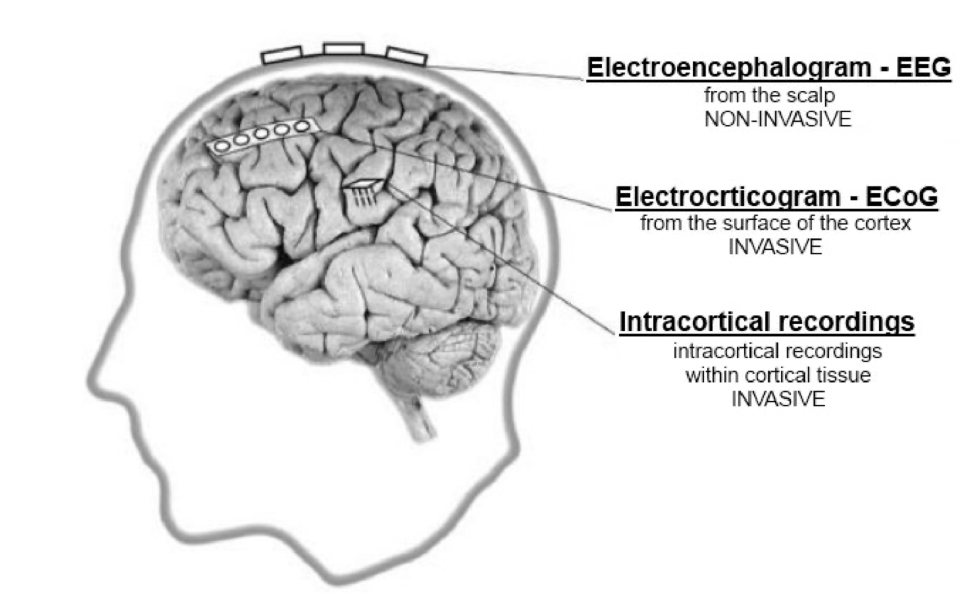
Figure 2. Three different methods for electrical activity of brain recordings